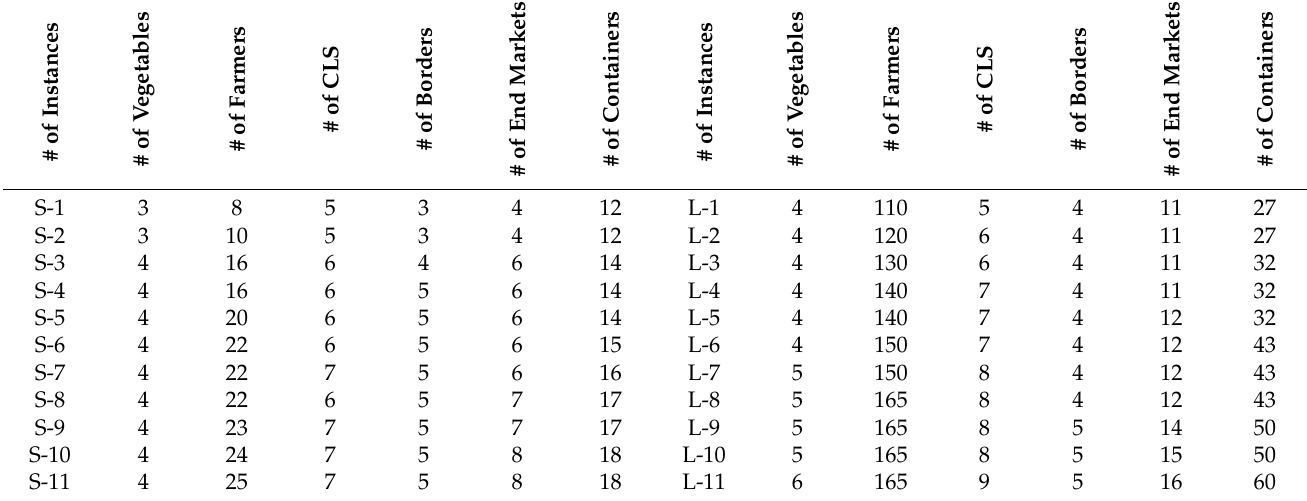
Table 10. Details of the test instances.